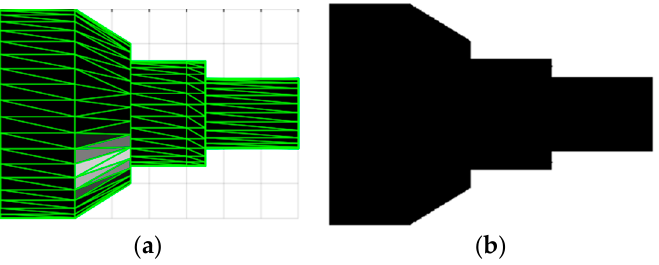
Figure 8. Converted CAD model from STL to BMP image file. ( a ) 2D projection of a 3D model on 2D grid container, ( b ) Intensity image for contained models, ( c ) Binary scale of image (b).